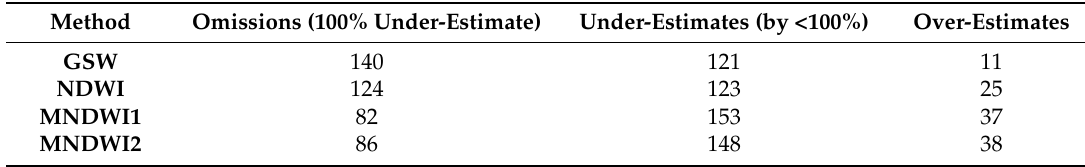
Table 2. Number and type of errors in reservoir area estimates (n = 272) derived from GSW, NDWI, MNDWI1, and